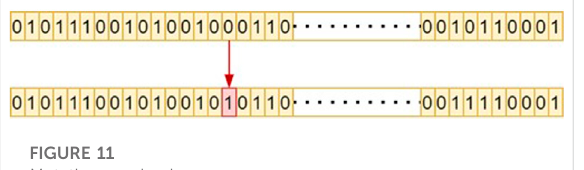
FIGURE 11 Mutation